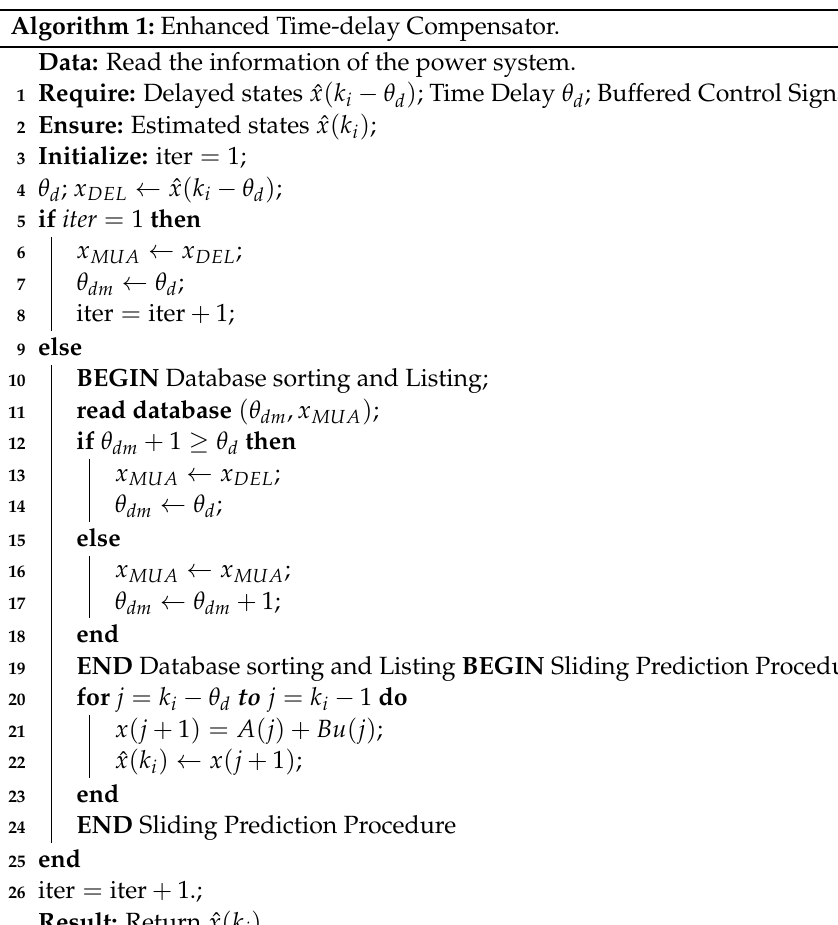
Algorithm 1: Enhanced Time-delay Compensator. Data: Read the information of the power